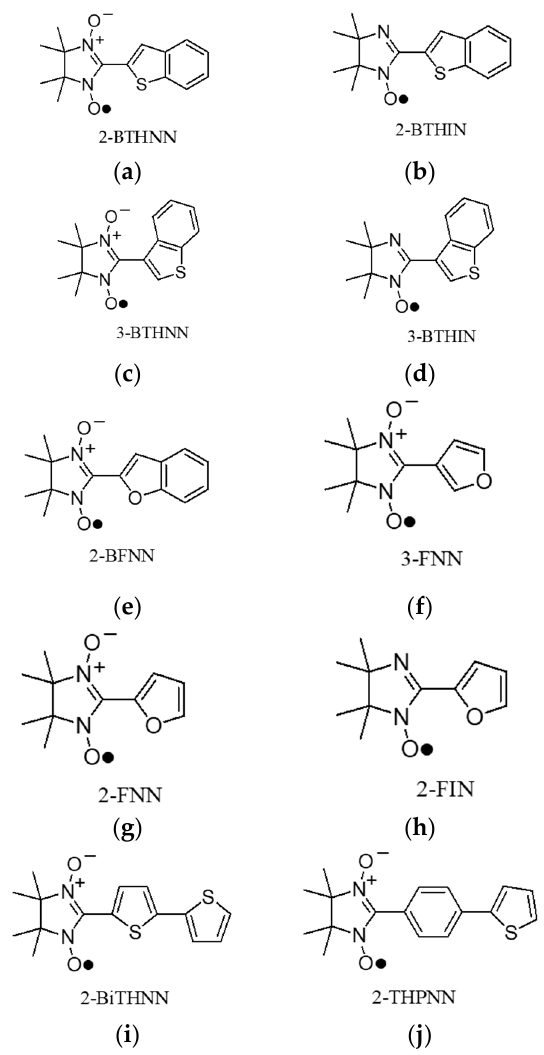
Figure 1. Molecular structures of organic radicals reported here. ( a ) 2-BTHNN, ( b ) 2-BTHIN, ( c ) 3-BTHNN, ( d ) 3-BTHIN, ( e ) 2-BFNN, ( f ) 3-FNN, ( g ) 2-FNN, ( h ) 2-FIN, ( i ) 2-BiTHNN, and ( j ) 2-THPNN (see the text for the abbreviated names).